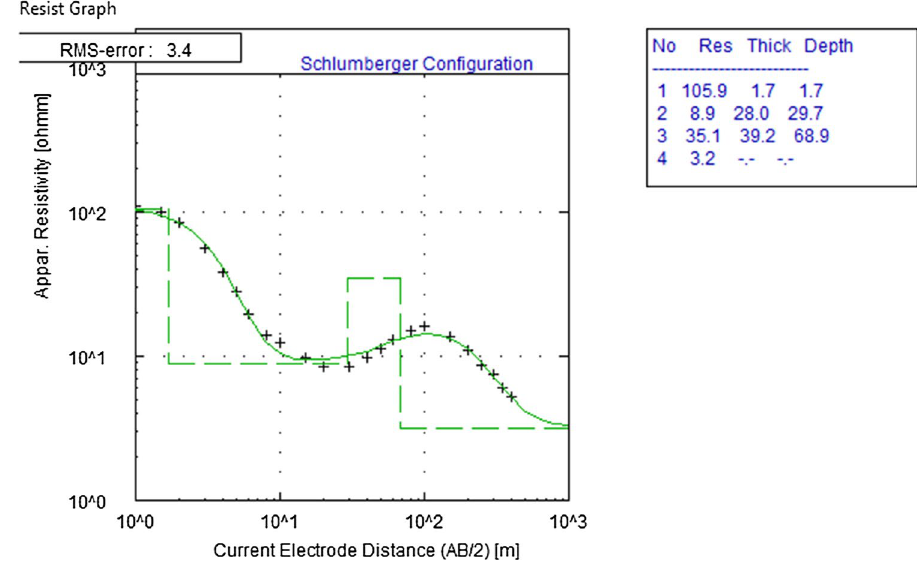
Fig. 4 Typical VES model obtained in the